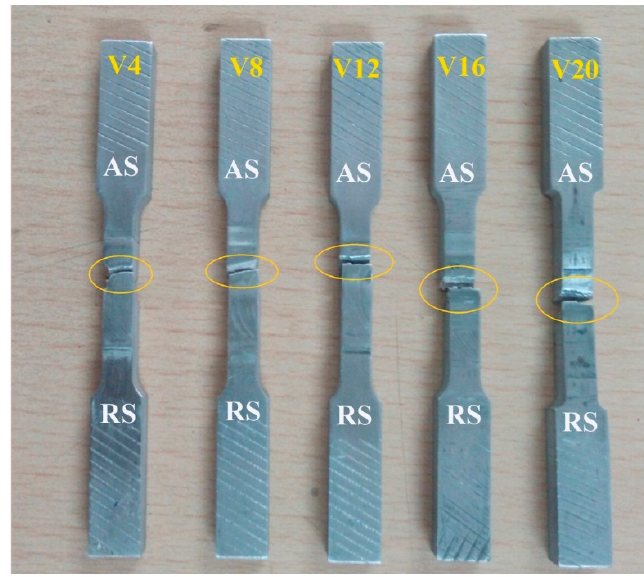
Figure 13. Typical fractured regions of the tensile test specimens.